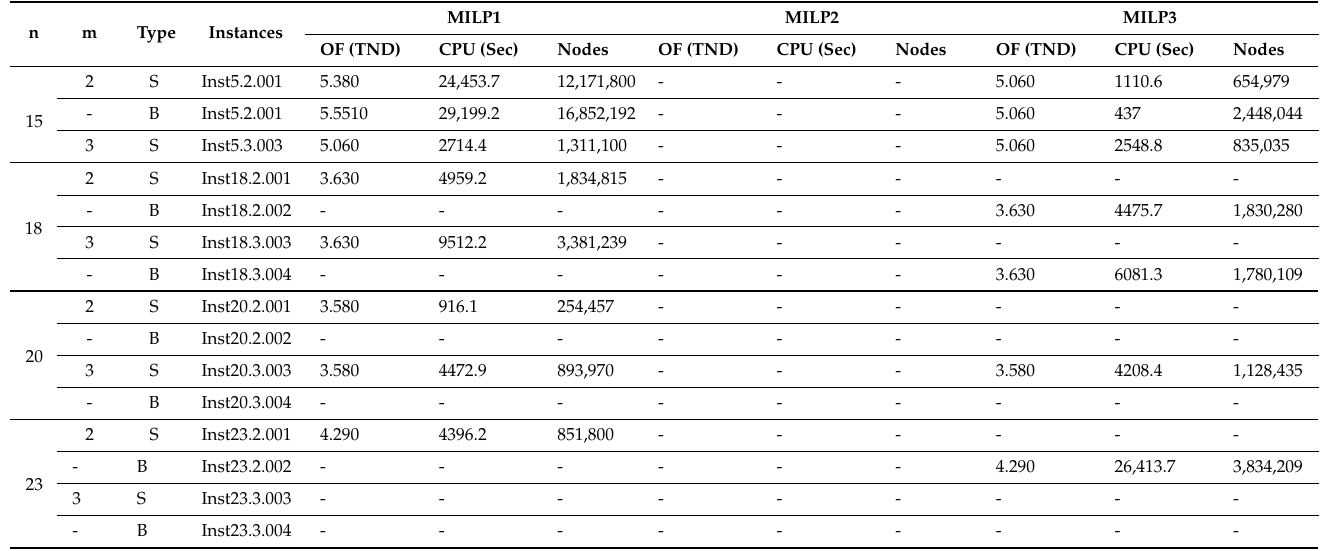
Table 3. High demand and customers number